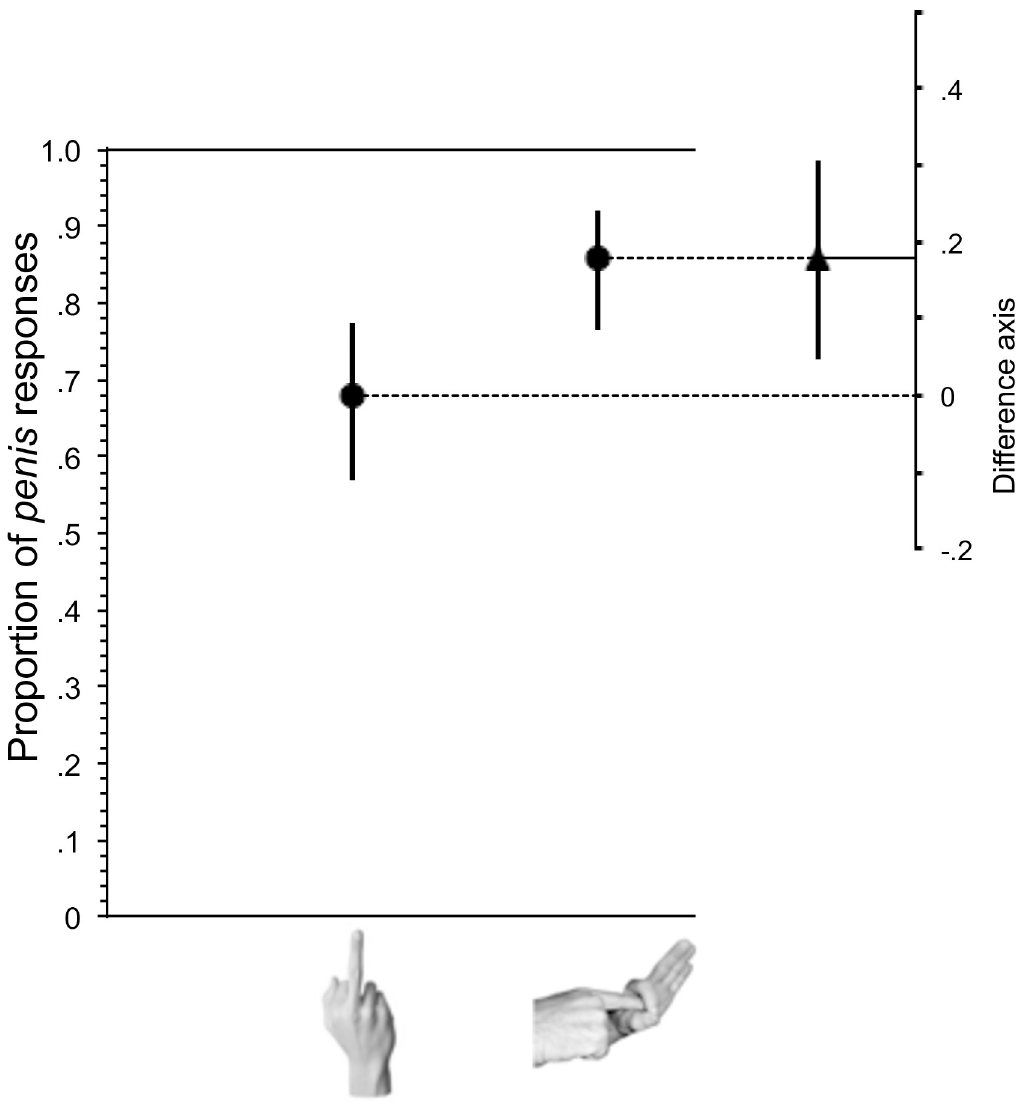
Fig 5. Effect of preceding gesture on completion of word completion prompt: p e n _ _. The proportion of penis completions of the p e n _ _ stem was significantly higher following the Finger-Bang gesture than the Middle-Finger gesture. Whiskers indicate 95% confidence intervals. The difference between the group values, with its 95% confidence interval, is shown on a floating difference axis at the right.